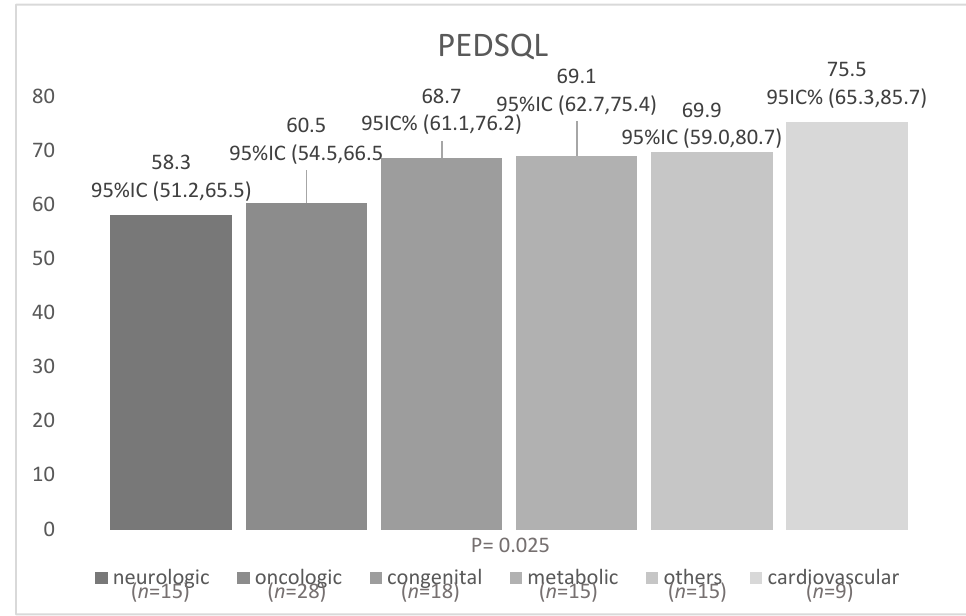
Figure 2. ANOVA of PEDSQL by complex chronic condition groups (perceived by Children). Those parents with higher educational levels and occupational status perceived a better HRQL for their children. Among the fathers, the difference was statistically significant relative to those with only a minimal education level in the summary score: − 19.40 95% CI ( − 36.4, to − 2.4); on the psychosocial scale, − 18.6 95% CI ( − 34.8, to − 2.5); and − 13.27 ( − 30.8, to 4.2) at primary school. Among the mothers, there were significant differences in the psychosocial domain, − 10.1 95%CI ( − 18.3, to − 1.7), in respect to mothers without qualifications. Furthermore, regarding the occupational status, differences were detected in the total score among fathers employed in managerial positions, − 17.34 95%CI ( − 32, to − 2.6), and intermediate positions, − 11.7 95%CI ( − 23.3, to − 0.1), relative to fathers who were unemployed or retired. In the psychosocial domain, differences were statistically significant for all occupations: managerial, − 21 95%CI ( − 32.9, to − 9.1); intermediate, − 13.5 95%CI ( − 24.8, to − 2.1); and unqualified, − 15.6 95%CI ( − 26.7, to − 4.4); relative to parents who were unemployed or retired ( p < 0.001). Among the mothers, there were no significant differences by occupational status. No differences were detected in the HRQL perceived by the children, according to the occupational status, or education of their parents (Table 2).